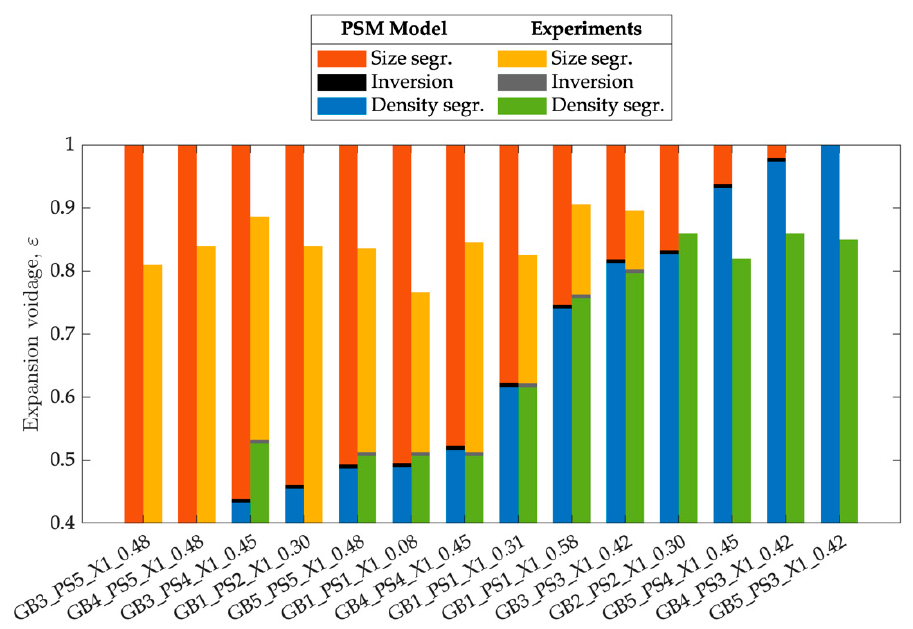
Figure 9. Histogram plot comparing the segregation direction and the inversion voidage between the PSM model predictions and the experimental measurements. Color codes are illustrated in the legend: blue and green indicate segregation dominated by density, red and orange segregation dominated by size and the black and grey lines denote the inversion voidage. Note that the maximum height of the experimental bar indicates the highest voidage achieved in the column for each test. The systems are sorted by increasing predicted inversion voidage. Solids and mixture properties are available in Tables 1 and 3.